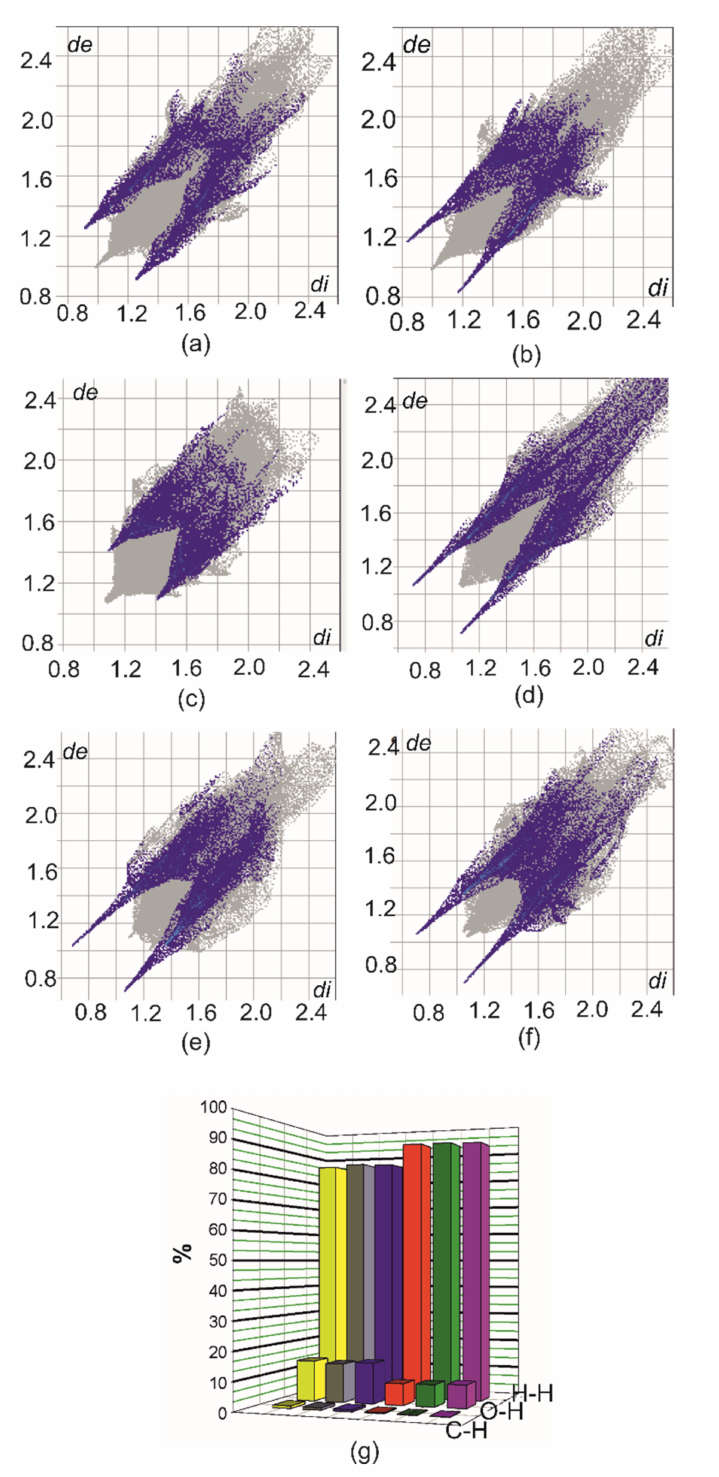
Figure 12. Contribution of O ··· H intermolecular interactions to the Hirshfeld surface area for molecules ( a ) A and ( b ) B in R 3-but-OA , molecules in ( c ) P 2 1 -but-OA , ( d ) Me-GE , and molecules ( e ) A and ( f ) B in Me-11-oxo-OA : ( g ) The percentage of H ··· H, O ··· H and C ··· H interactions for ( a ) A (purple) and ( b ) B molecules (green) in R 3-but-OA , molecules in ( c ) P 2 1 -but-OA (red), ( d ) Me-GE (dark blue), and molecules ( e ) A (gray) and ( f ) B (yellow) in Me-11-oxo-OA . Bars from purple to yellow represent molecules in the order of this caption for fingerprint